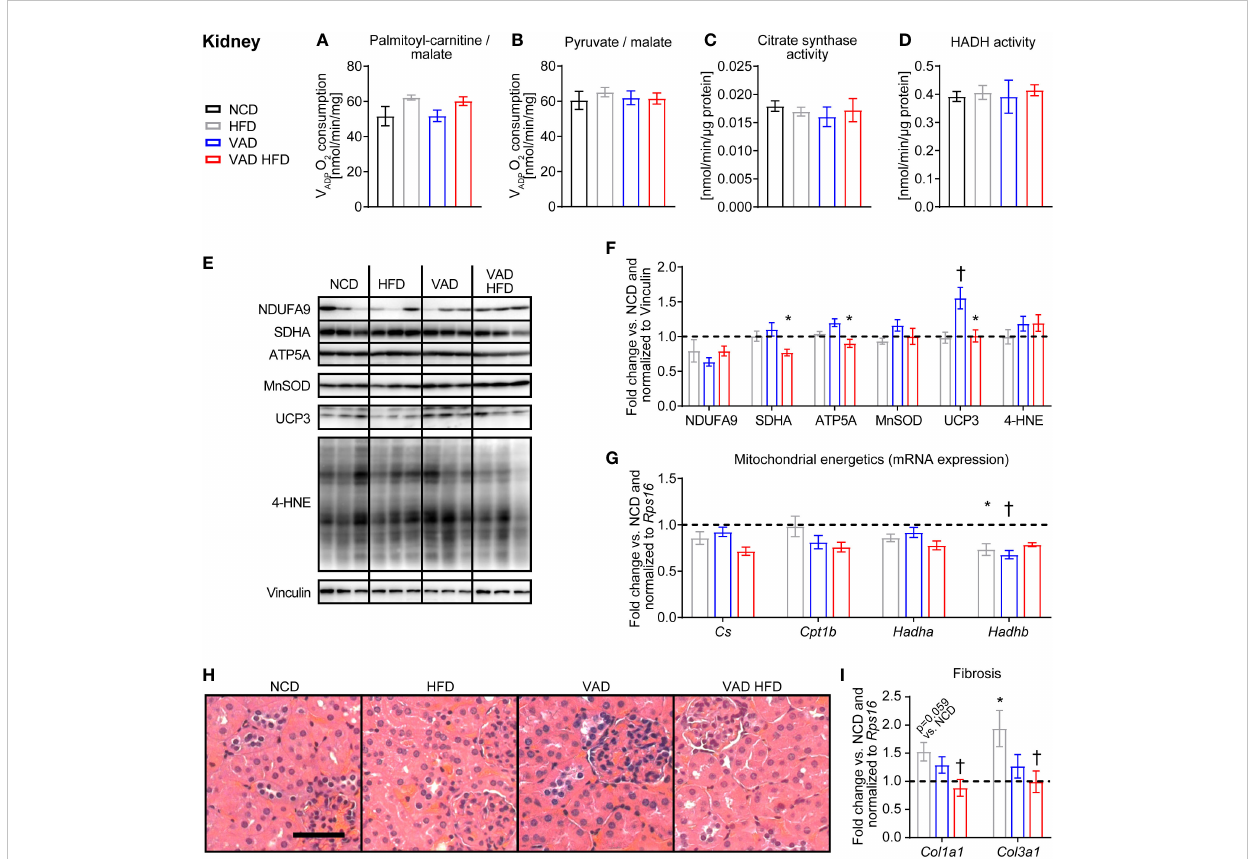
FIGURE 4 VitA mediates the pro- fi brotic transcriptional response in kidney tissue following HFD feeding independent of mitochondrial energetics. Data are reported as mean values ± SE. Two-way ANOVA was performed to analyze differences by HFD feeding and VitA. Results of post-hoc analyses for each comparison are summarized by symbols as de fi ned: # p<0.05 for HFD feeding, $ p<0.05 for VitA, and & p<0.05 for the interaction between HFD feeding and VitA. V ADP of isolated kidney mitochondria with (A) palmitoyl-carnitine (#) and (B) pyruvate each combined with malate as substrates (n=6-8). (C) Citrate synthase and (D) HADH activity in kidney tissue (n=7-8). (E) Representative immunoblots and (F) densitometric analysis of NDUFA, SDHA (&), ATP5A (&), MnSOD, UCP3 (#, $, &), and 4-HNE normalized to Vinculin. Data are presented as fold change relative to NCD (assigned as 1.0; dashed line), n=6. (G) mRNA expression of transcripts involved in mitochondrial energetics ( Cs: #; Cpt1b: $; Hadha: #; Hadhb: $, &). Data are presented as fold change relative to NCD and normalized to Rps16 (assigned as 1.0; dashed line), n=8. (H) Representative H&E stains of kidney sections (scale bar: 50 m m). (I) mRNA expression of transcripts involved in organ fi brosis ( Col1a1: &; Col3a1: &). Data are presented as fold change relative to NCD and normalized to Rps16 (assigned as 1.0; dashed line), n=8. *p < 0.05 vs. normocaloric diet same VitA availability, † p<0.05 vs. VitA suf fi ciency same caloric